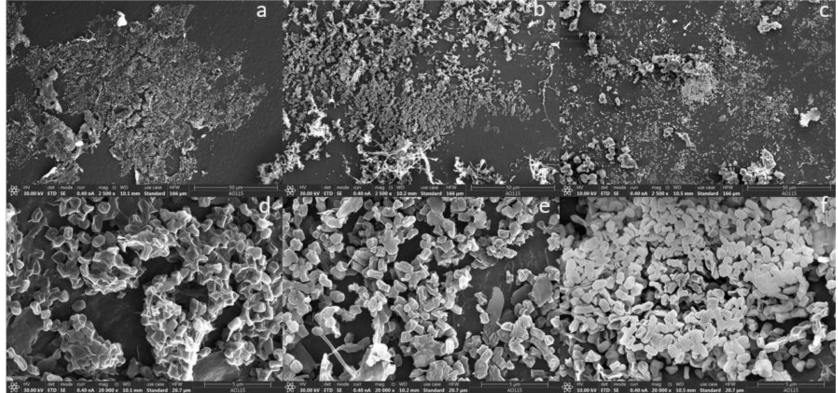
Figure 7. SEM micrographs of a bacterial consortium ( Arthrobacter sp. and Streptomyces sp.) attached to the polyethylene film surface. Unpretreated plastic film (UPF) at 2500 × magnification ( a ) and 20,000 × magnification ( d ). Weathered plastic film (WPF) at 2500 × magnification ( b ) and 20,000 × magnification ( e ). Buried plastic film (BPF) at 2500 × magnification ( c ) and 20,000 × magnification ( f